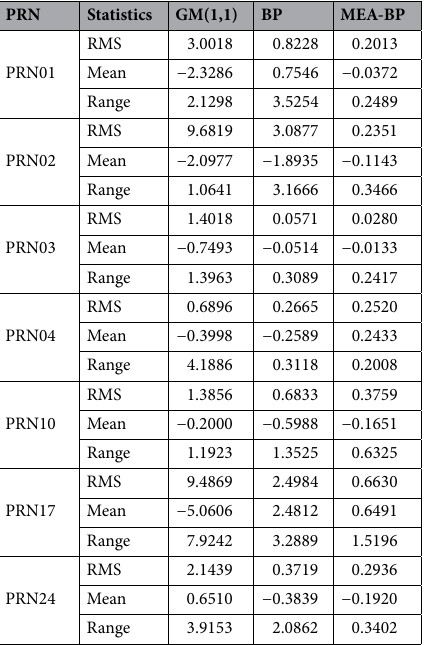
Table 5. Statistics of 2 h prediction results of the seven satellites (unit: